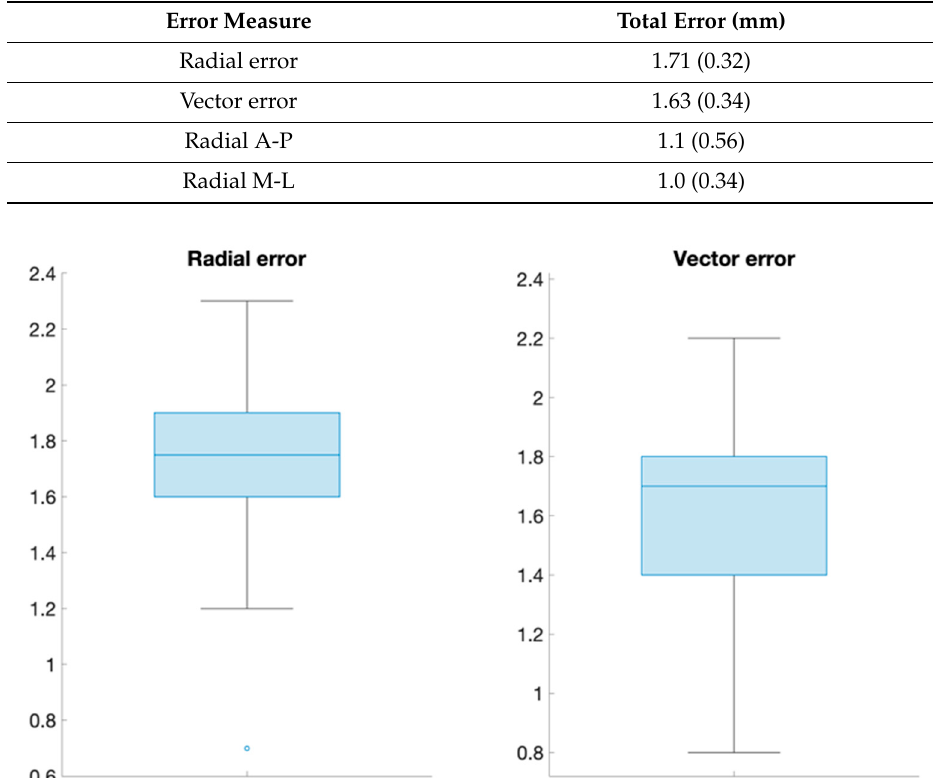
Table 2. Final values of the radial and vector errors according to Toms et al. [9].